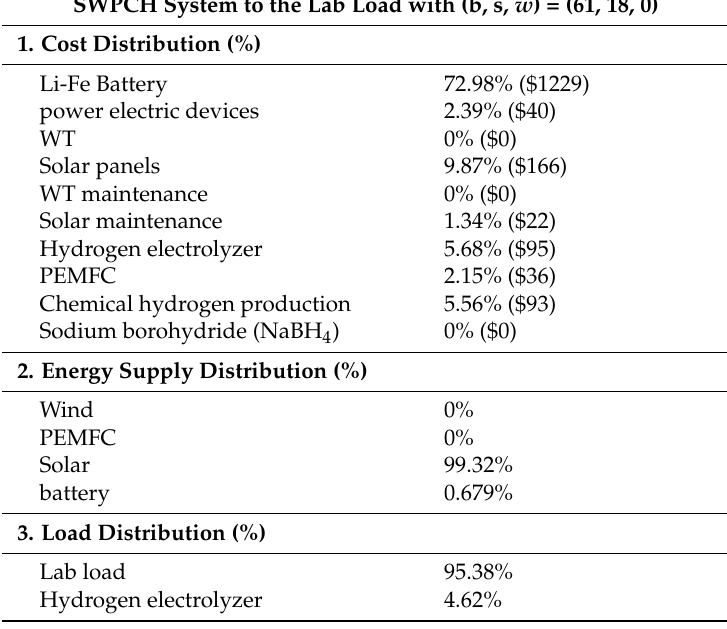
Table 4. The distribution of cost, energy sources, and